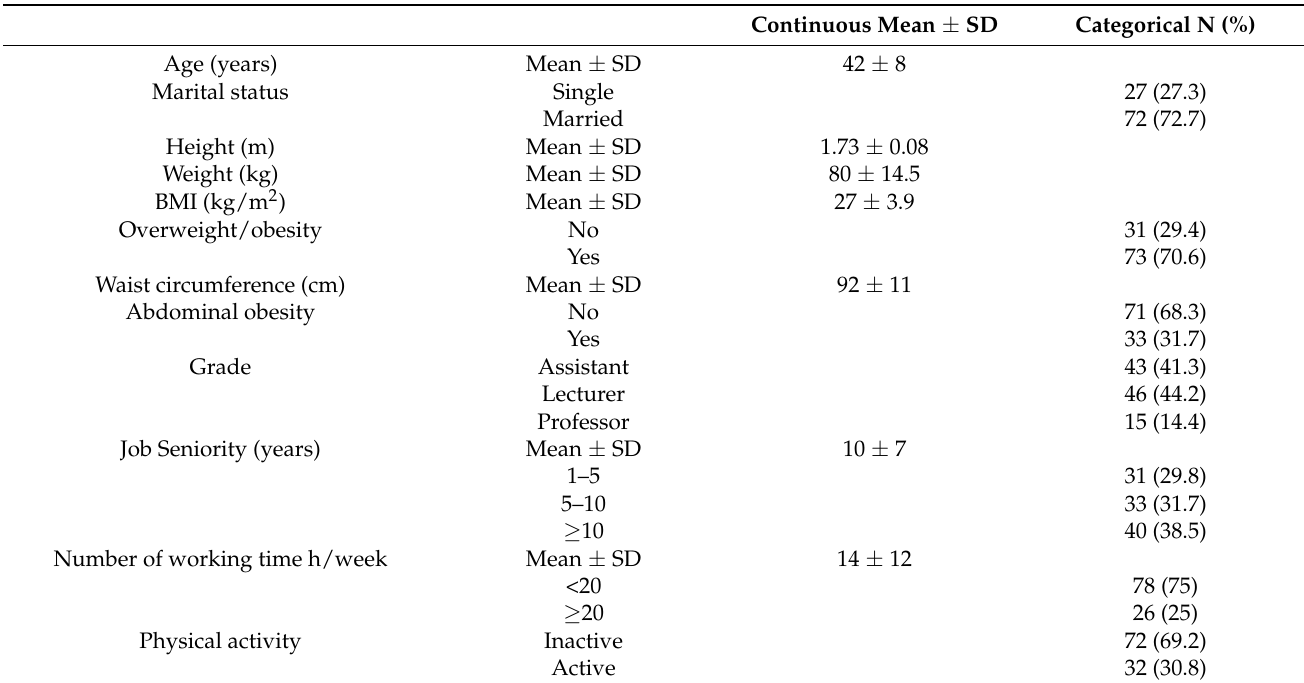
Table 2. Characteristics of study